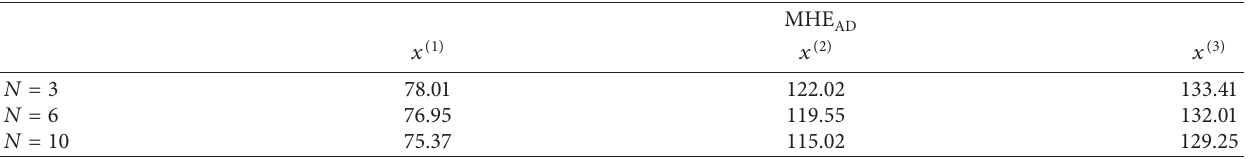
Figure 9: Performance of MHE with N � 3, N � 6, and N � 10: (a) estimation of x ( 1 ) ; (b) estimation of x ( 2 ) ; (c) estimation of x ( 3 ) . AD Table 4: Comparison of the effect of the horizon size on the average sum square estimation error for states: x ( 1 ) , x ( 2 ) , and x ( 3 )